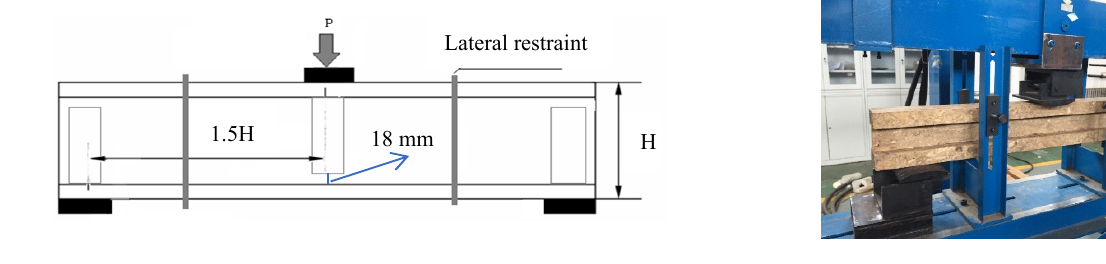
Figure 2. Shear test loading device and schematic diagram.